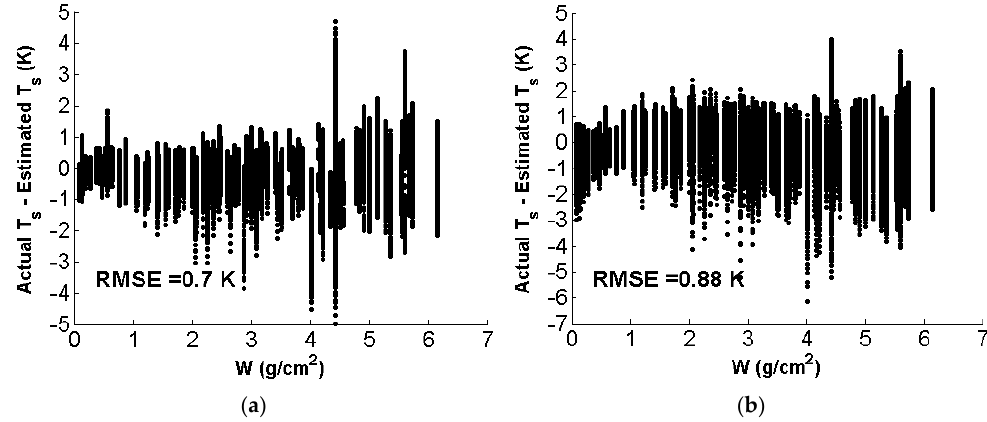
Figure 12. The error distributions for ( a ) the algorithm in this study and ( b ) Sobrino’s algorithm.